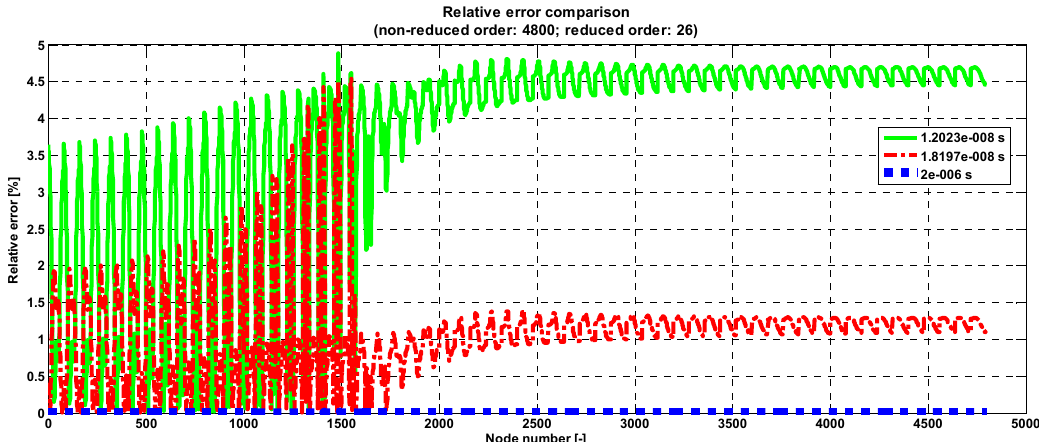
Figure 7. Comparison of relative error values in relation to a number of discretization mesh node for selected time points (t = 12.023 ns, t = 18.197 ns, and t = 2 µs) .